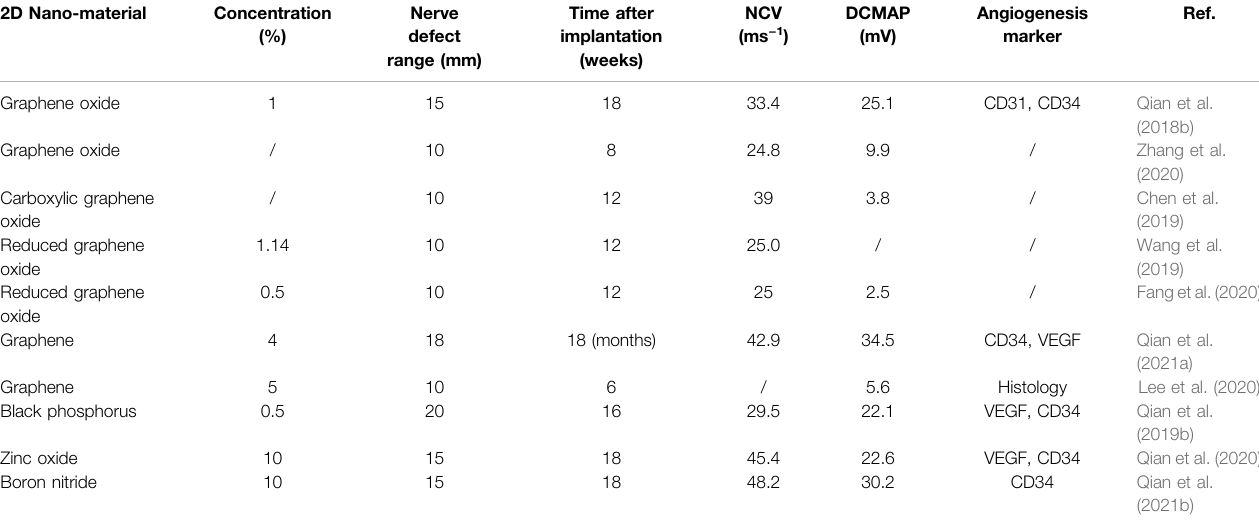
TABLE 1 | Therapeutic effects of the 2D nanomaterial functionalized nerve scaffold in vivo . 2D